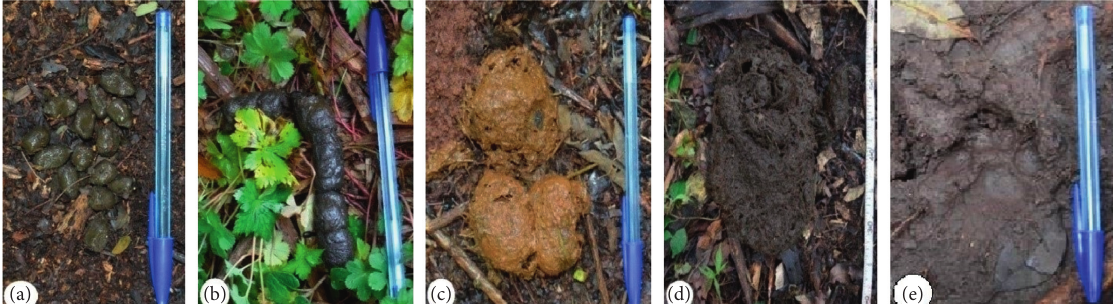
Figure 5: Scats and foot print of large mammals recorded at Nensebo forest, Southern Ethiopia. (a) Mountain nyala; (b) common jackal; (c) warthog; (d) giant forest hog; (e) leopard (photo: Zerubabel Worku,